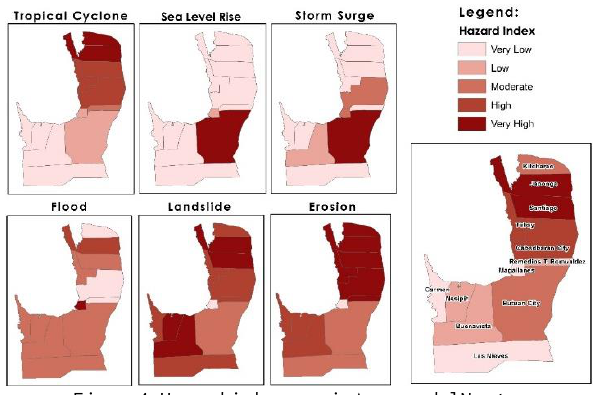
Figure 4. Hazard index map in Agusan del Norte.